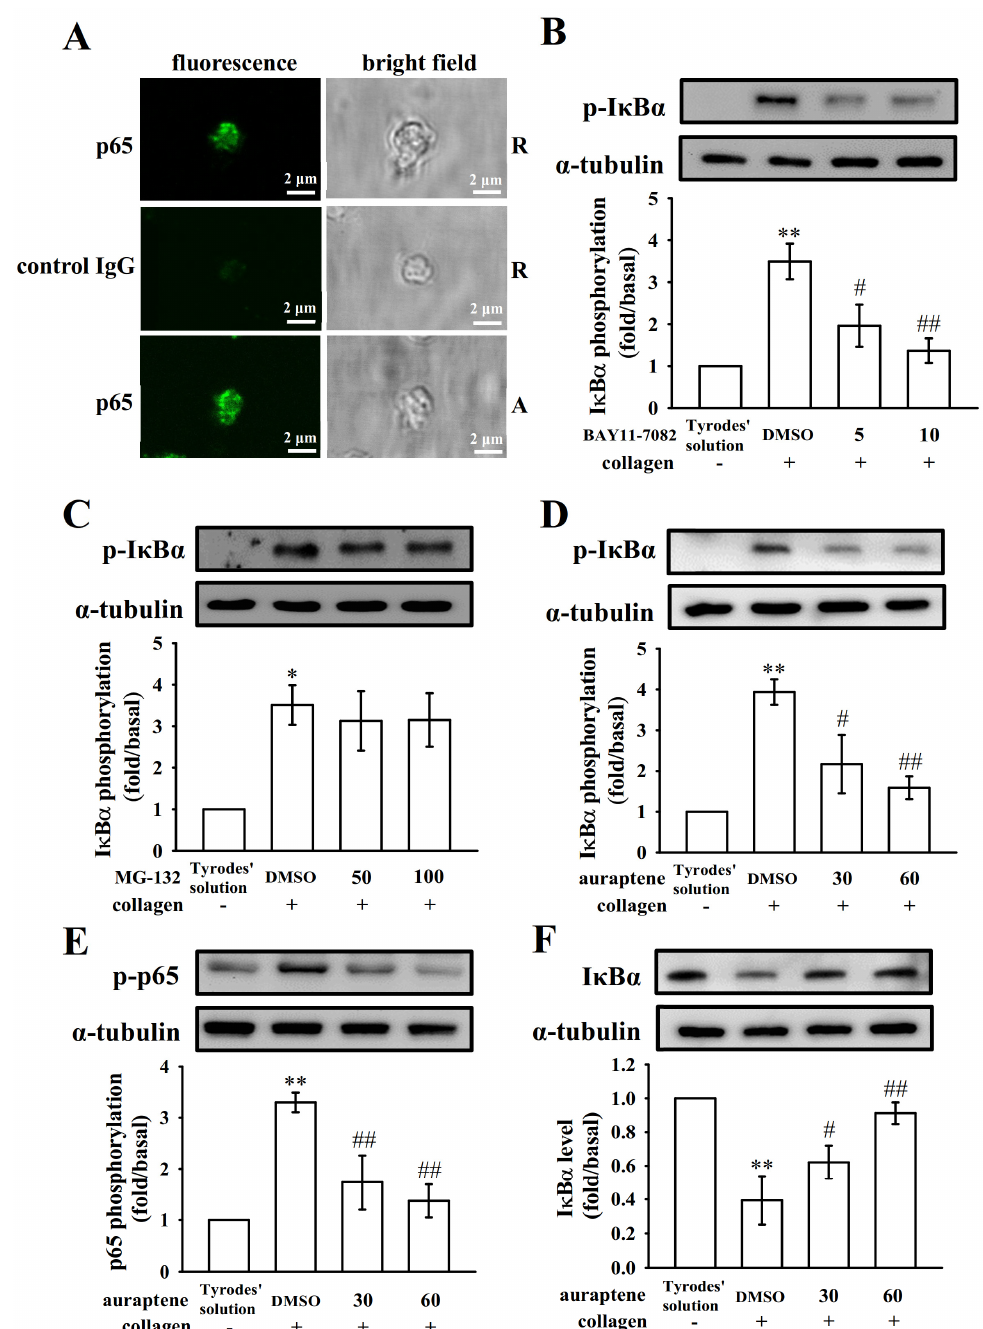
Figure 2. Effects of NF- κ B activation by BAY11-7082, MG-132, and auraptene in platelets. ( A ) The confocal image (10 × 100 magnification) of NF- κ B (p65) in resting (R) or collagen-activated (A) platelets. p65 or control IgG was labeled with goat anti-rabbit IgG-conjugated FITC (shown in green color) as described in Materials and Methods. For other experiments, washed platelets were preincubated with a solvent control (0.1% DMSO), BAY11-7082 (5 and 10 µ M), MG-132 (50 and 100 µ M), or auraptene (30 and 60 µ M), followed by the addition of collagen (1 µ g / mL) to trigger ( B – D ) I κ B α and ( E ) p65 phosphorylation, or ( F ) I κ B α protein degradation. Profiles ( A ) are representative examples of four similar experiments. The corresponding statistical data displayed in B–F. Data are presented as mean ± SEM ( n = 4). * p < 0.05 and ** p < 0.01 compared with the resting control (Tyrode’s solution); # p < 0.05 and ## p < 0.01, compared with the 0.1% DMSO-treated